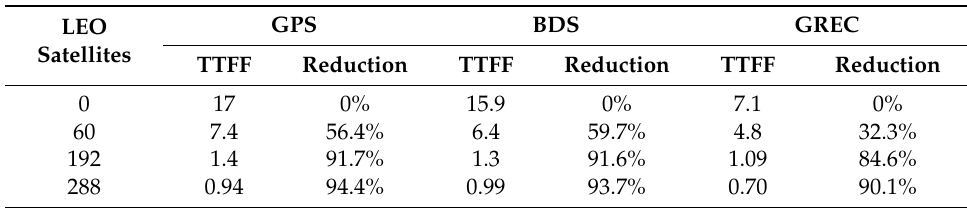
Table 1. TTFF of GPS, BDS, and GREC PPP AR without or with the augmentation of 60, 192, and 288 LEO satellites (unit: